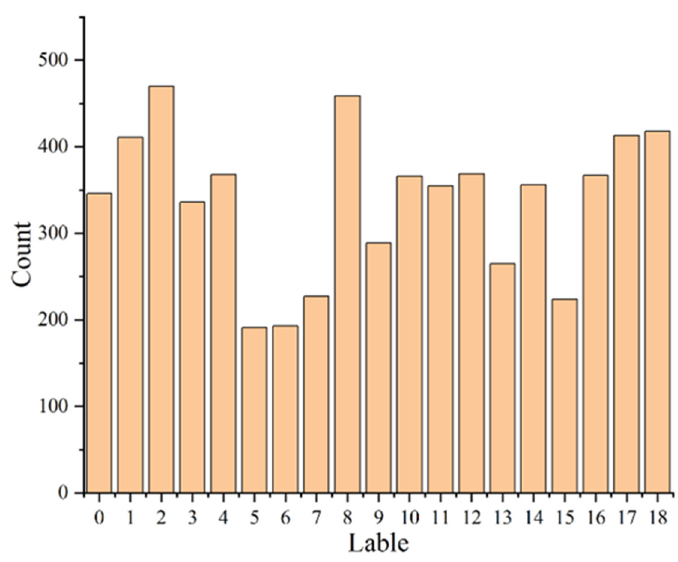
Figure 4. Data distribution and labeling.